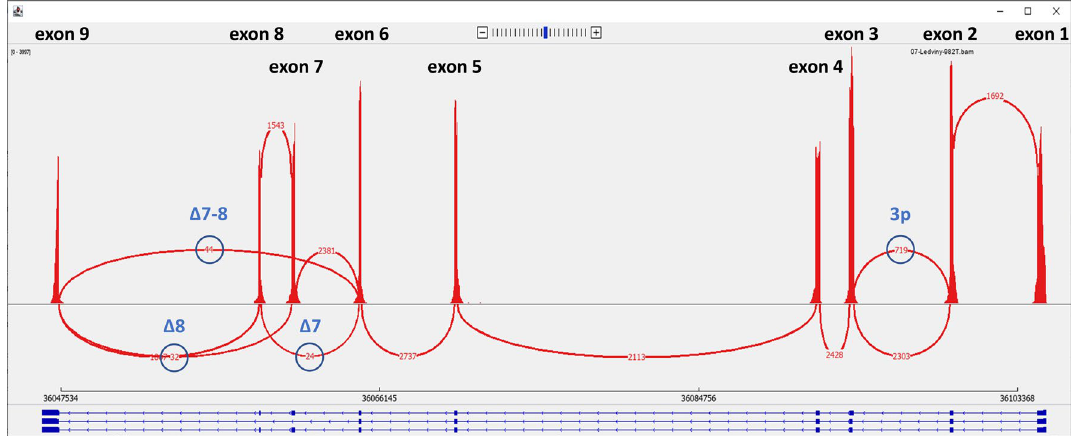
Figure 5. Representative example of the HNF1B splicing pattern based on the capture RNA-Seq of a kidney T sample visualised as a sashimi plot in IGV (Broad Institute). The height of the peaks shows exon coverage, the red lines show splicing reads, the red numbers in the red lines show the number of splicing reads, the ASVs are indicated in blue font and the number of ASVs’ reads is circled. The dark blue scheme under the plot shows the gene structure of the protein coding HNF1B transcripts (blue boxes indicate exons; thin horizontal lines indicate introns). The cut-off for visualisation of the splicing reads was set to 10. The results are provided in Table 3.